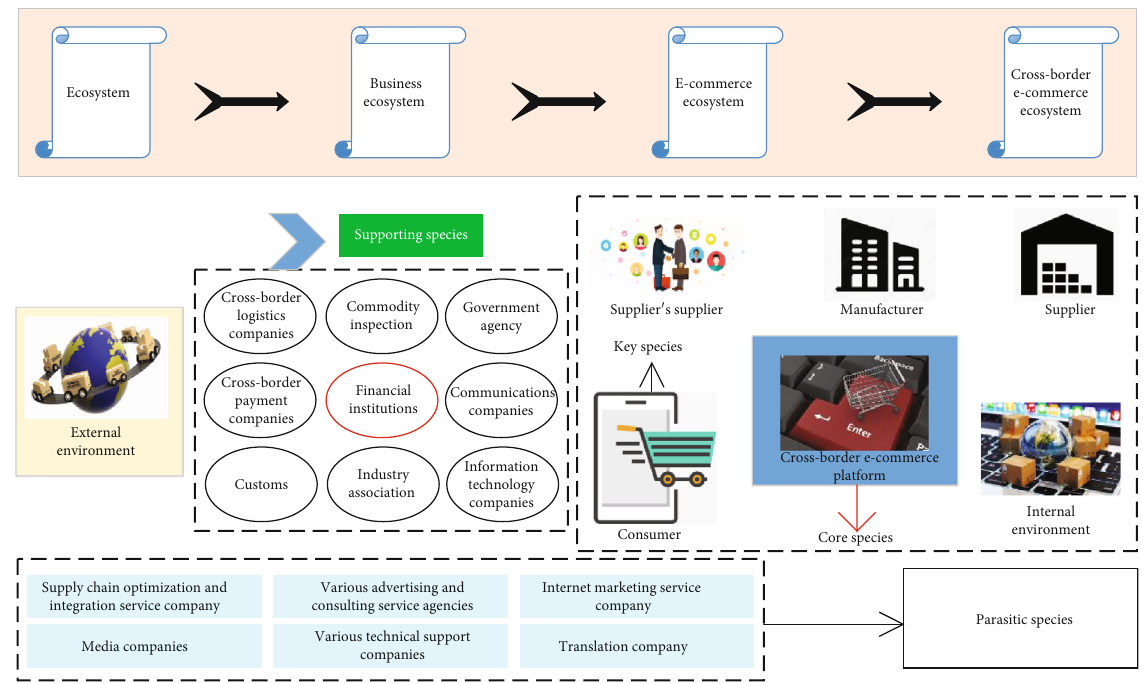
Figure 1: Cross-border e-commerce ecosystem